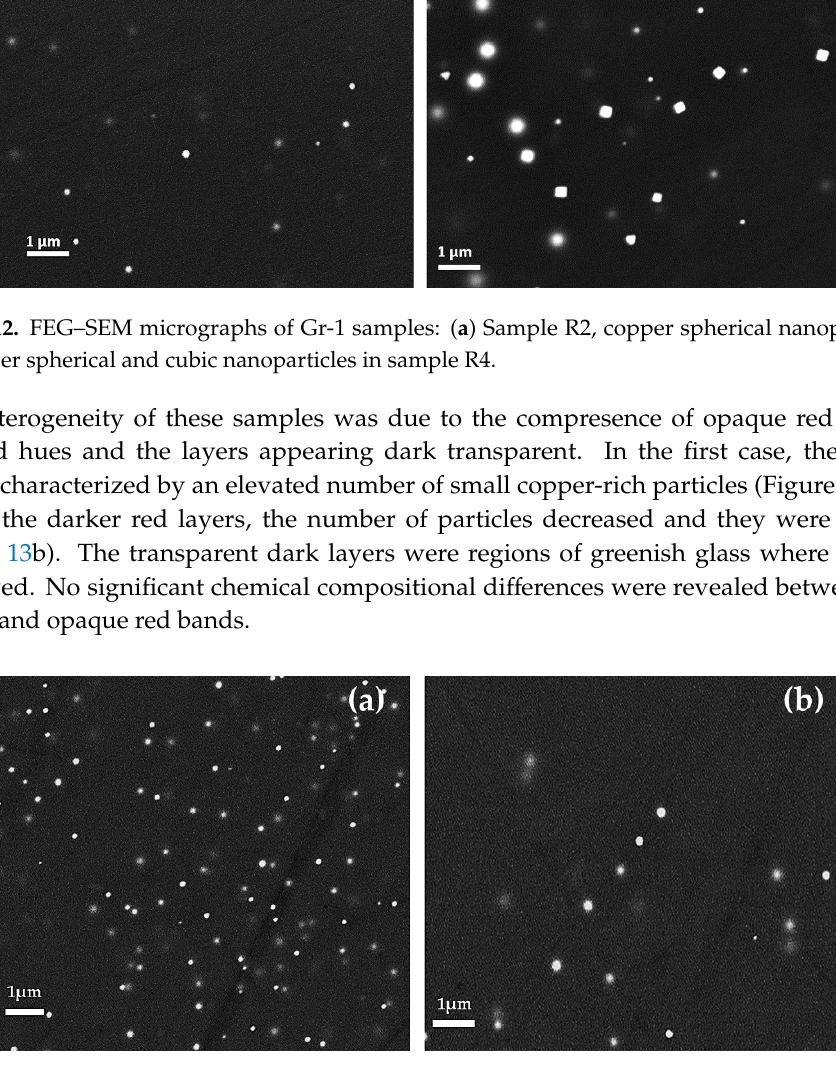
Figure 14. FEG–SEM micrographs of sample R10 (Gr-2 group). ( a ) Different dimensions of the copper- rich particles—few and large platelet-type (line in cross-section) and abundant but much smaller copper-rich particles; and ( b ) copper-rich particles at higher magnification. The dark transparent and the opaque red layers of the samples of Gr-3 group were analysed separately by FEG–SEM. No considerable compositional differences were detected between the two layers; only the red layers were a result of being richer in iron (R1: 5.4 wt.%; R22: 4.5 wt.%) than the dark transparent areas (R1: 4.6 wt.%; R22: 3.3 wt.%). A high number of copper-rich particles, in the range of between 50 and 100 nm, were observed in the red layers (Figure 15a,b). Particles rich in copper and sulphur (probably Cu 2 S), slightly larger than 1 μ m in size, were observed constantly in both the red and in the dark transparent layers.